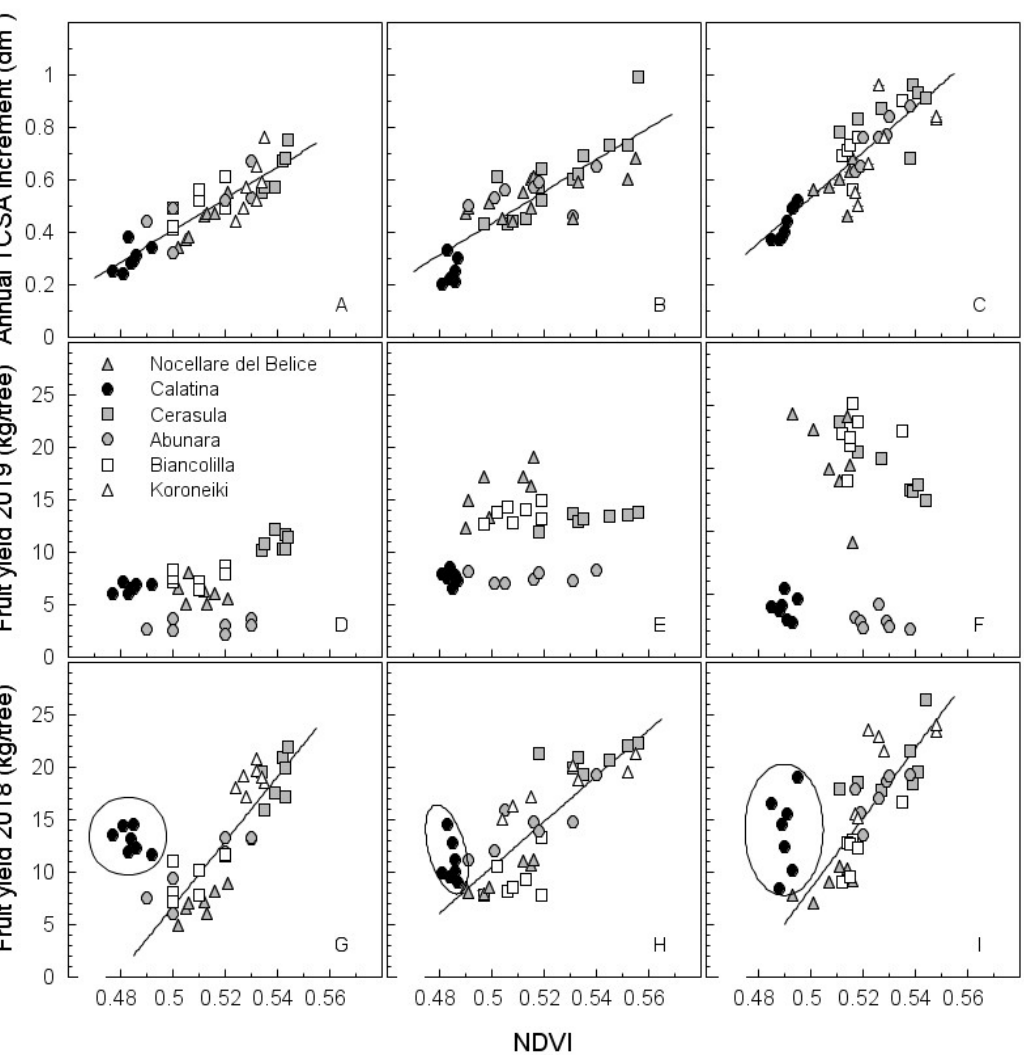
Figure 7. Relationship between the Normalized Difference Vegetation Index (NDVI) measured on February 2019 and the annual increment of trunk cross section area (TCSA) ( A – C ), the fruit yield measured in 2019 ( D – F ) and fruit yield measured in 2018 ( G – I ) of olive trees of different cultivars planted at the 4 × 2 m ( A , D , G ), 4 × 3 m ( B , E , H ) and 4 × 4 m ( C , F , I ). Each symbol represent one tree. The values of Calatina trees were not included in the regression analysis ( G – I ). Equation: annual TCSA increment = 5.7 NDVI - 2.5, R 2 = 0.69 ( A ); annual TCSA increment = 6.4 NDVI – 2.7, R 2 = 0.66 ( B ); annual TCSA increment = 8.7 NDVI - 3.8, R 2 = 0.74 ( C ); fruit yield 2018 = 287 NDVI - 136, R 2 = 0.75 ( G ); fruit yield 2018 = 217 NDVI - 98 R 2 = 0.65 ( H ); fruit yield 2018 = 335 NDVI - 159 R 2 = 0.67 ( I